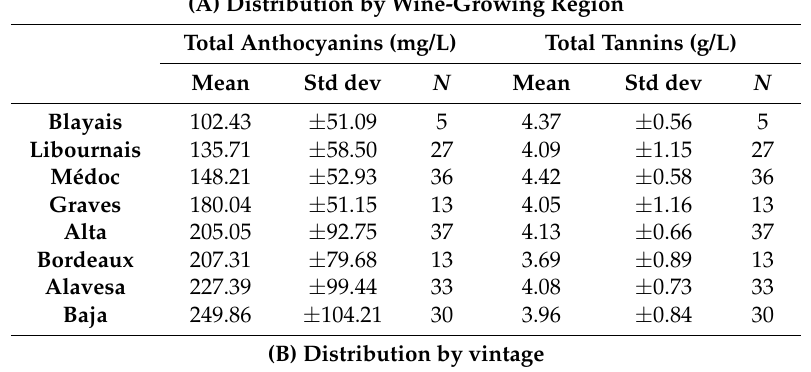
Table 1. Total anthocyanin and tannin contents distributed by wine-growing region ( A ) and vintage ( B ). (A) Distribution by Wine-Growing